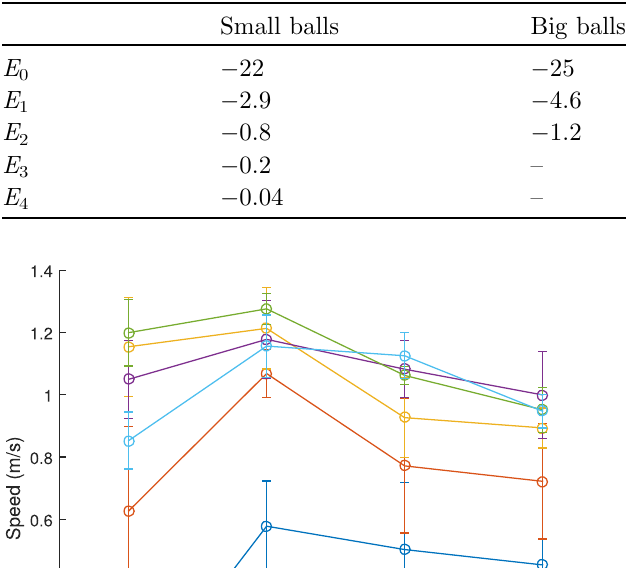
Table 1. Values of E